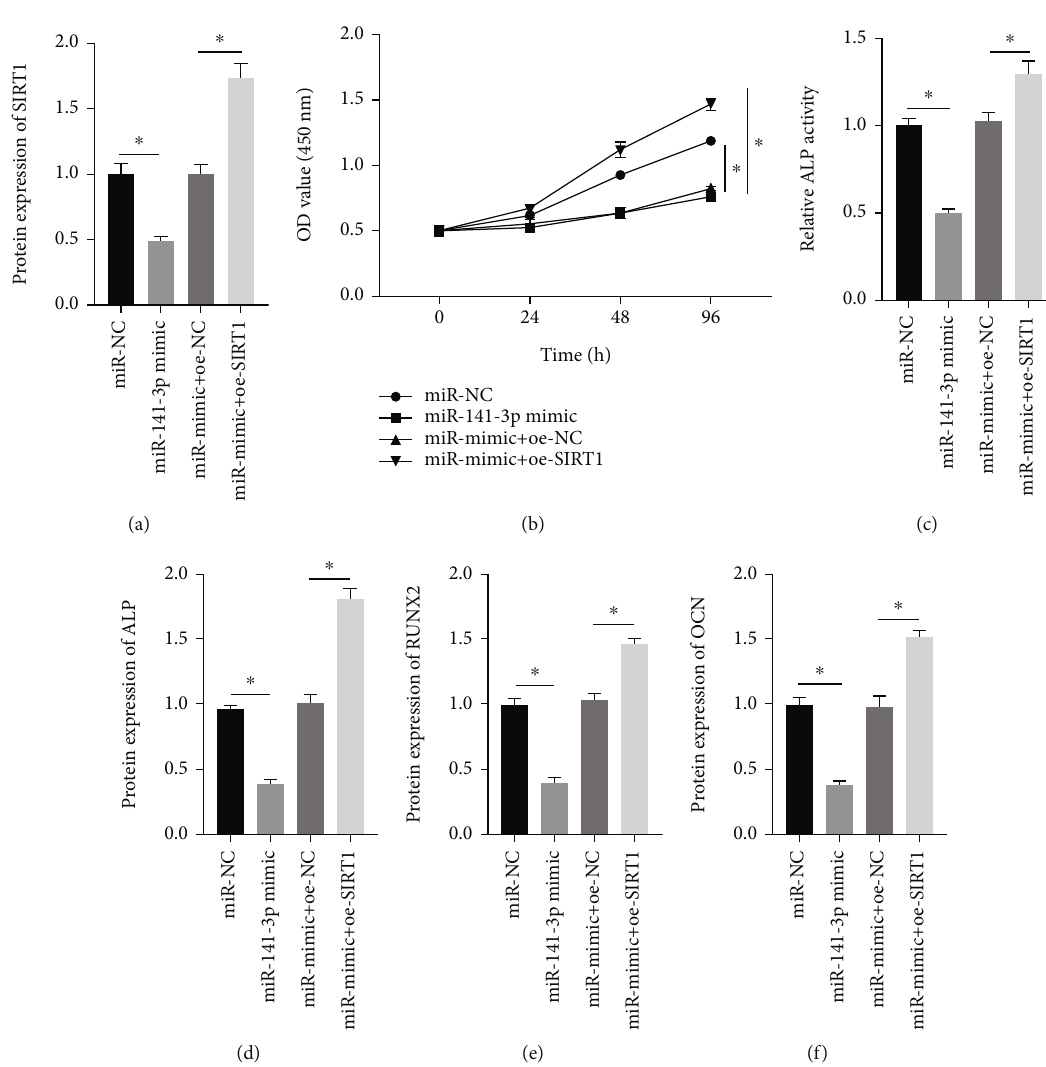
Figure 4: SIRT1 reversed the inhibitory in fl uence of miR-141-3p on osteogenic di ff erentiation ability of BMSCs. (a) miR-141-3p expression was examined. (b) CCK-8 assay was done to observe cell viability. (c) ALP activities were evaluated by spectrophotometry. (d) The mRNA expression (e) RUNX2, and (f) OCN were examined via RT-qPCR.